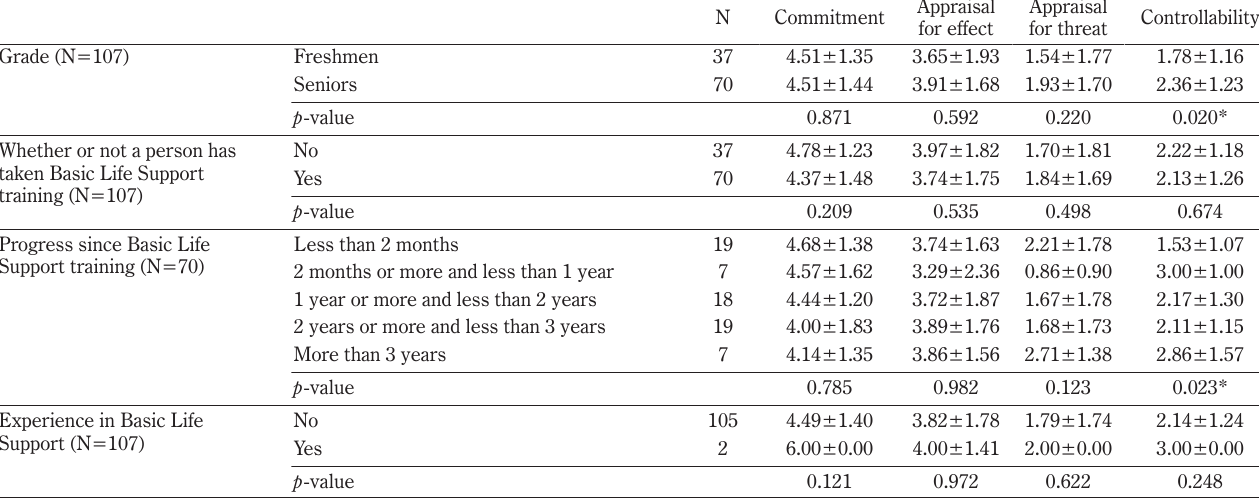
Table 4 Mean/standard deviation and significant difference of CARS for the characteristics